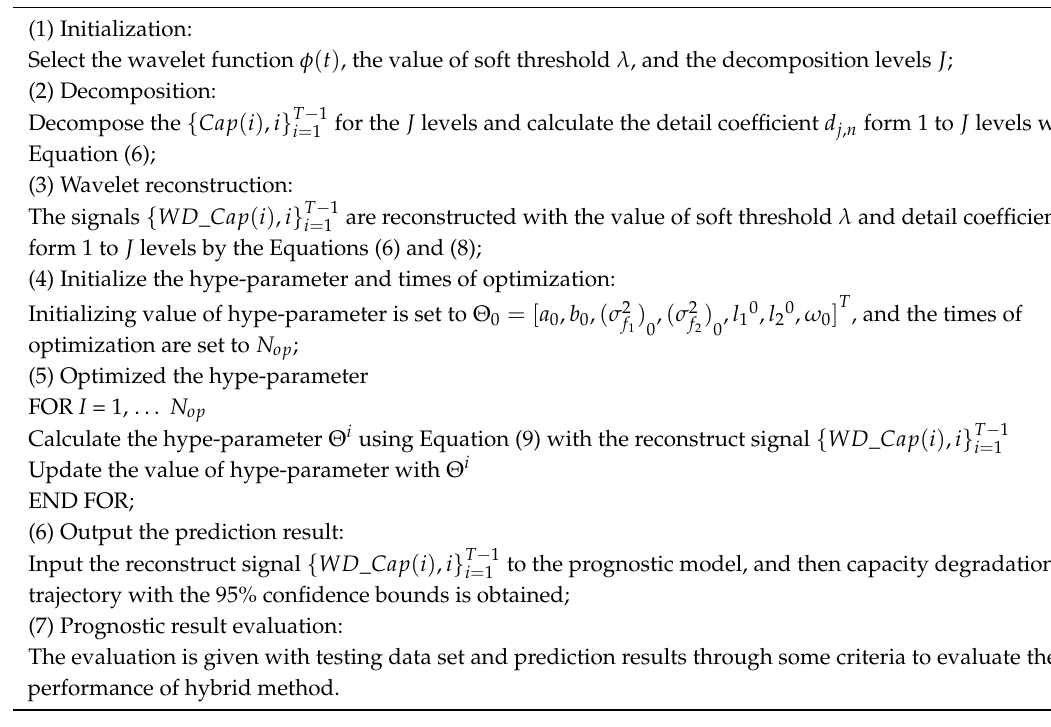
Algorithm 1. The hybrid method with WD method and HGPFR